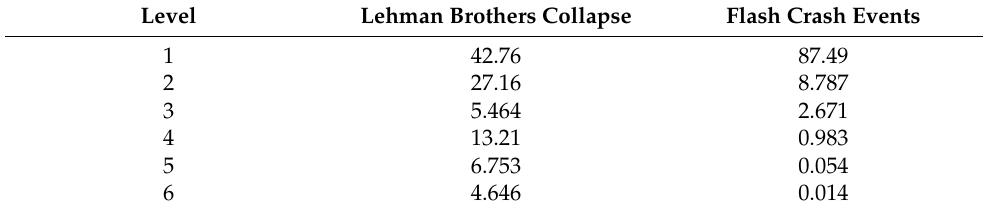
Table 10. Total energy for WMT stock market data.